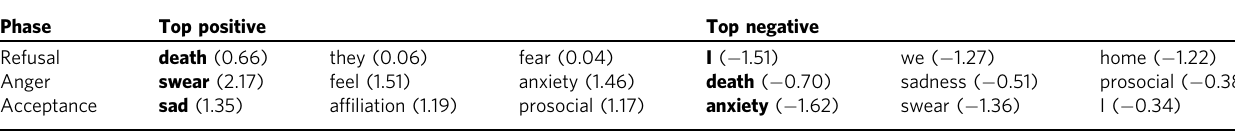
Table 4 Top three positive and bottom negative beta coef fi cients of the logistic regression models for the three phases.